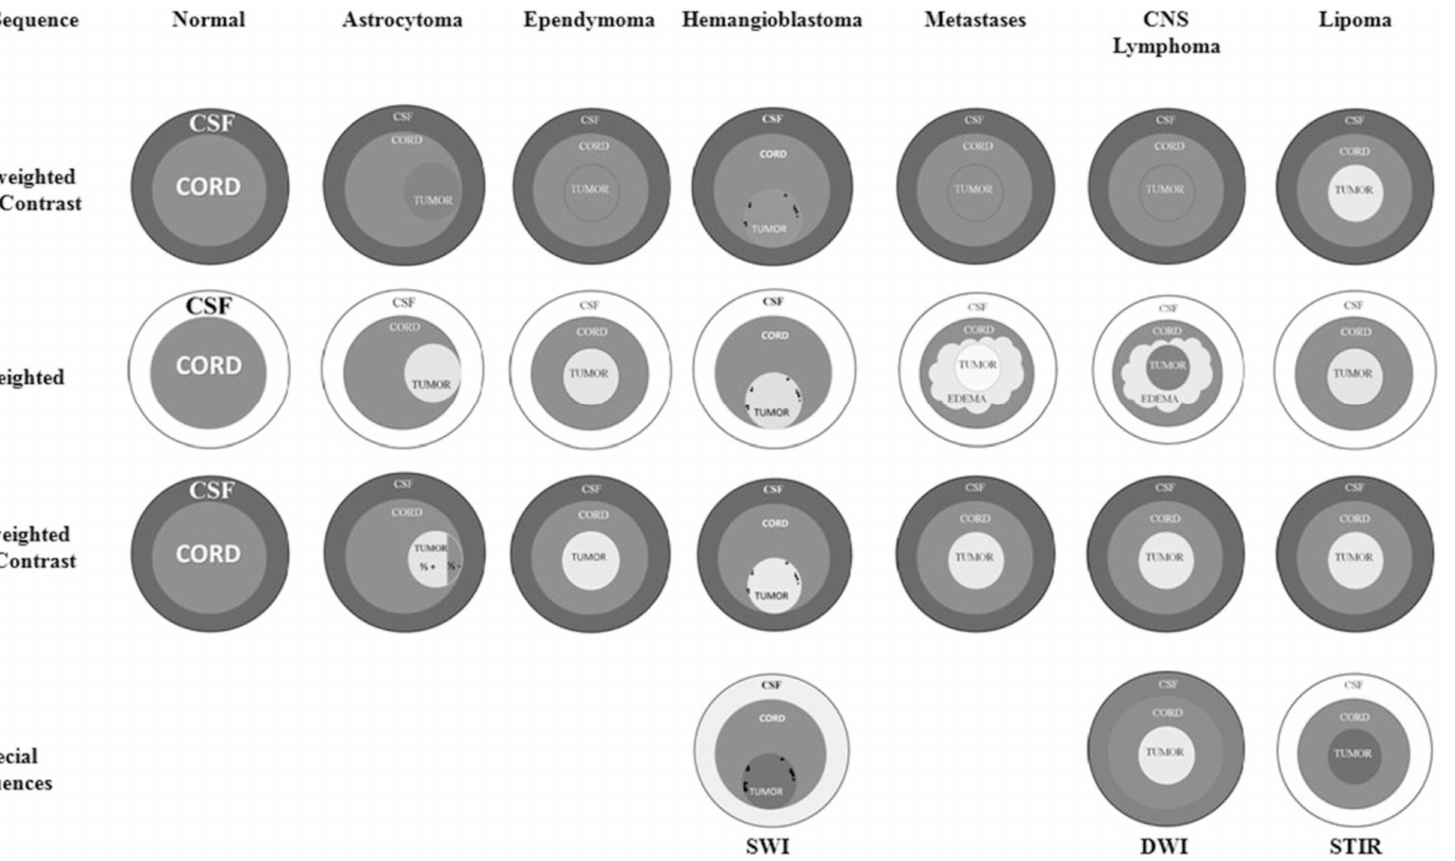
Figure 1. MRI appearance of different intramedullary spinal tumors. Adapted with permission from reference [48] Mechtler, L.L.; Nandigam, K. Spinal cord tumors: new views and future directions. Neurol. Clin. 2013 , 31 ,